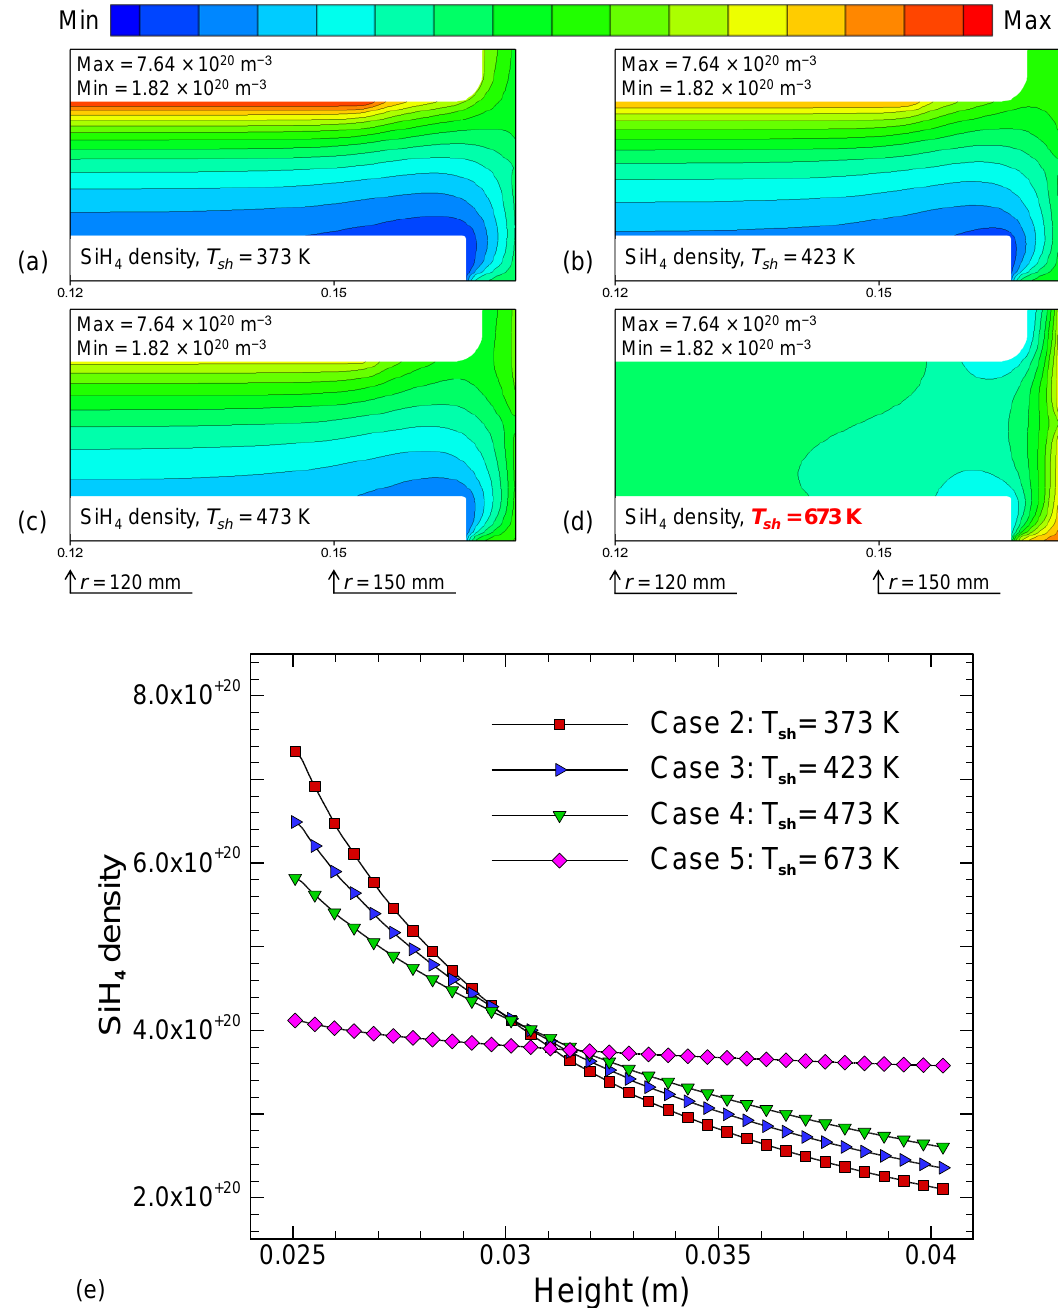
Figure 4. Effects of the showerhead temperature ( T sh ) on the spatial distribution of the reactive gas. Spatial variations in the SiH 4 density distributions (m −3 ) for ( a ) Case 2 ( T sh = 373 K), ( b ) Case 3 ( T sh = 423 K), ( c ) Case 4 ( T sh = 473 K), and ( d ) Case 5 ( T sh = 673 K) for r ≥ 120 mm. The profiles are radially uniform for r < 120 mm. ( e ) SiH 4 densities are plotted on the vertical line at r h ( r = 154.3 mm) for Cases 2, 3, 4, and 5.